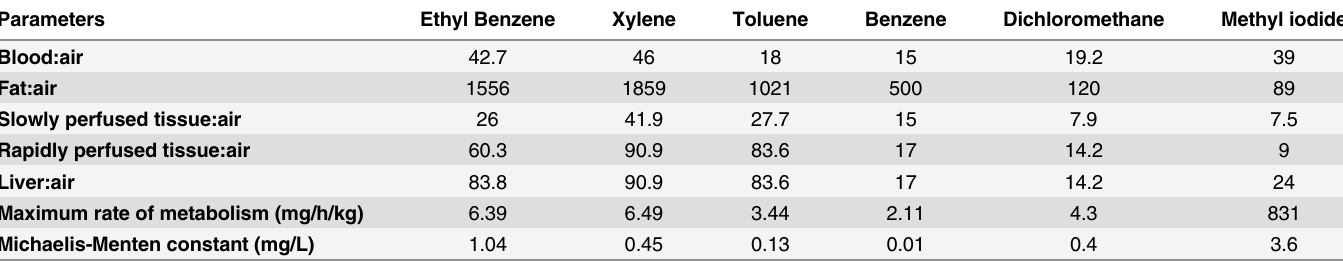
Table 2. Partition coefficients and metabolic parameters from existing PBPK models for ethylbenzene and selected analogues.